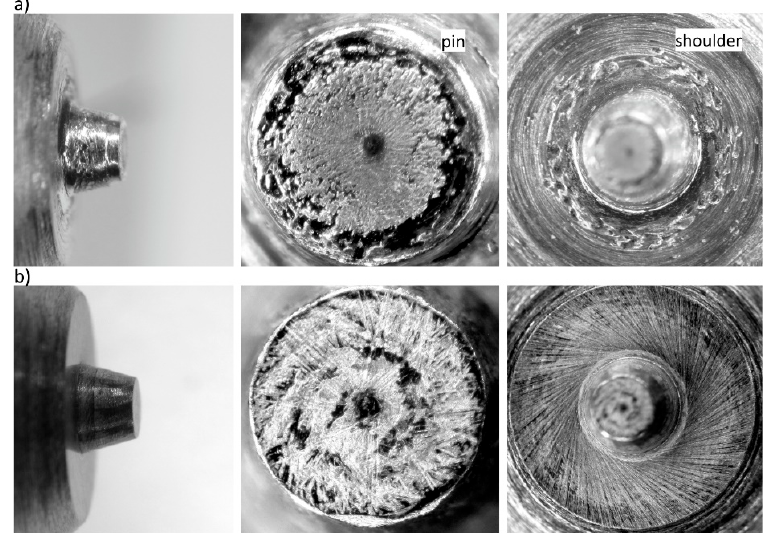
Figure 6. Toolworkingsurfaces(pinandshoulder)afterthefirststageoftesting(jointlengthofapproximately 100 m): ( a ) tool made of 1.2344 steel, ( b ) tool made of AlCrN coated 1.2344